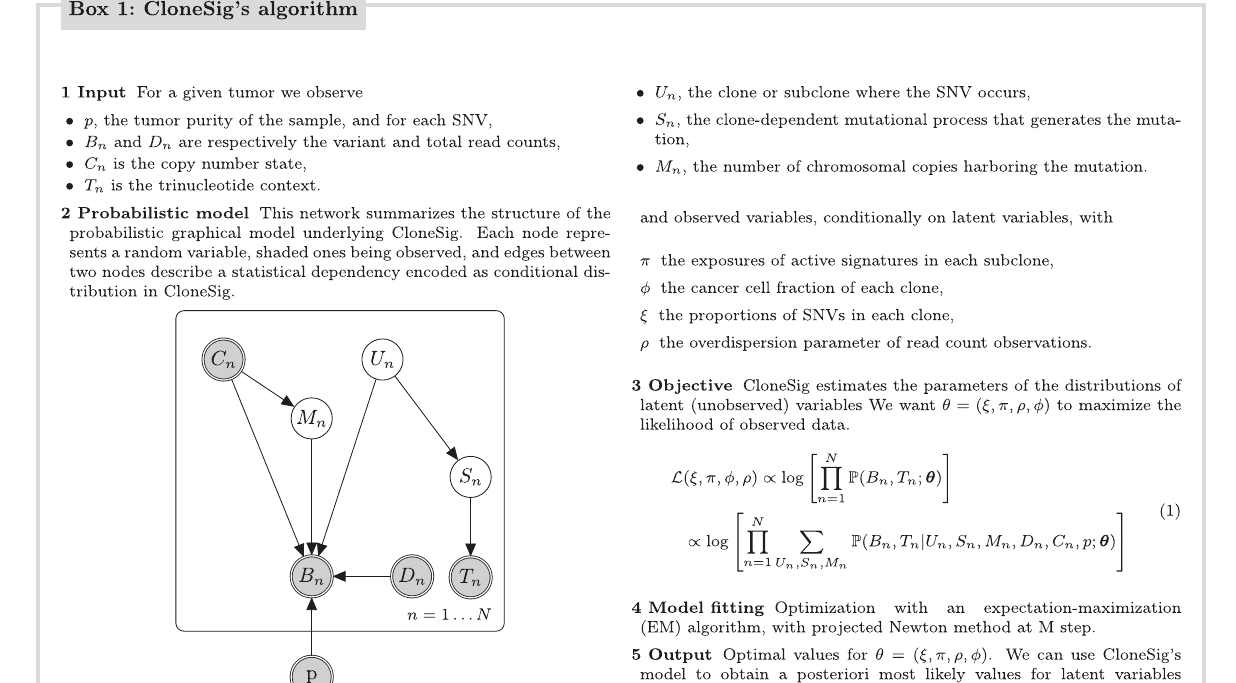
Box 1 | Probabilistic graphical model for CloneSig This plot summarizes the structure of the probabilistic graphical model underlying CloneSig. Each node represents a random variable, shaded ones being observed, and edges between two nodes describe a statistical dependency encoded as conditional distribution in CloneSig. For a given tumor we observe p , the tumor purity of the sample, and for each SNV, B n and D n are respectively the variant and total read counts, C n is the copy number state, and T n is the trinucleotide context. Unobserved latent variable include U n , the clone or subclone where the SNV occurs, S n , the clone-dependent mutational process that generates the mutation, and M n , the number of chromosomal copies harboring the mutation. See the main text for details about the distributions and parameters of the